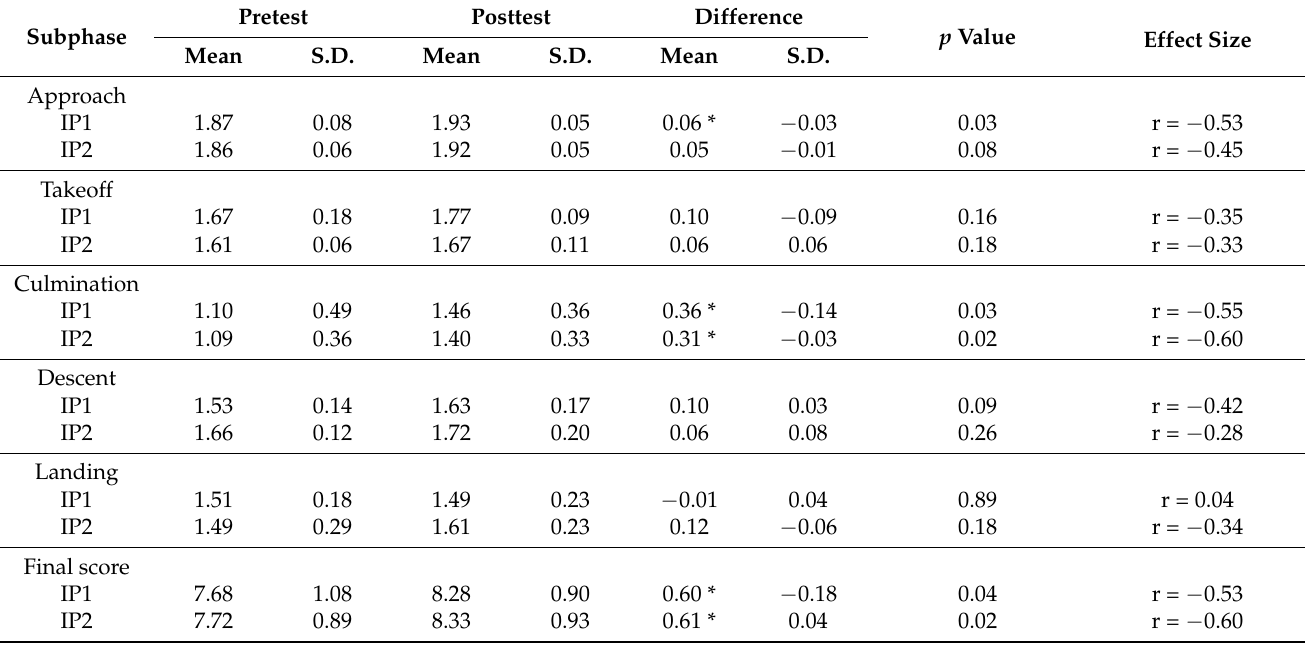
Table 2. Changes in the performance of the elements in IP1 and